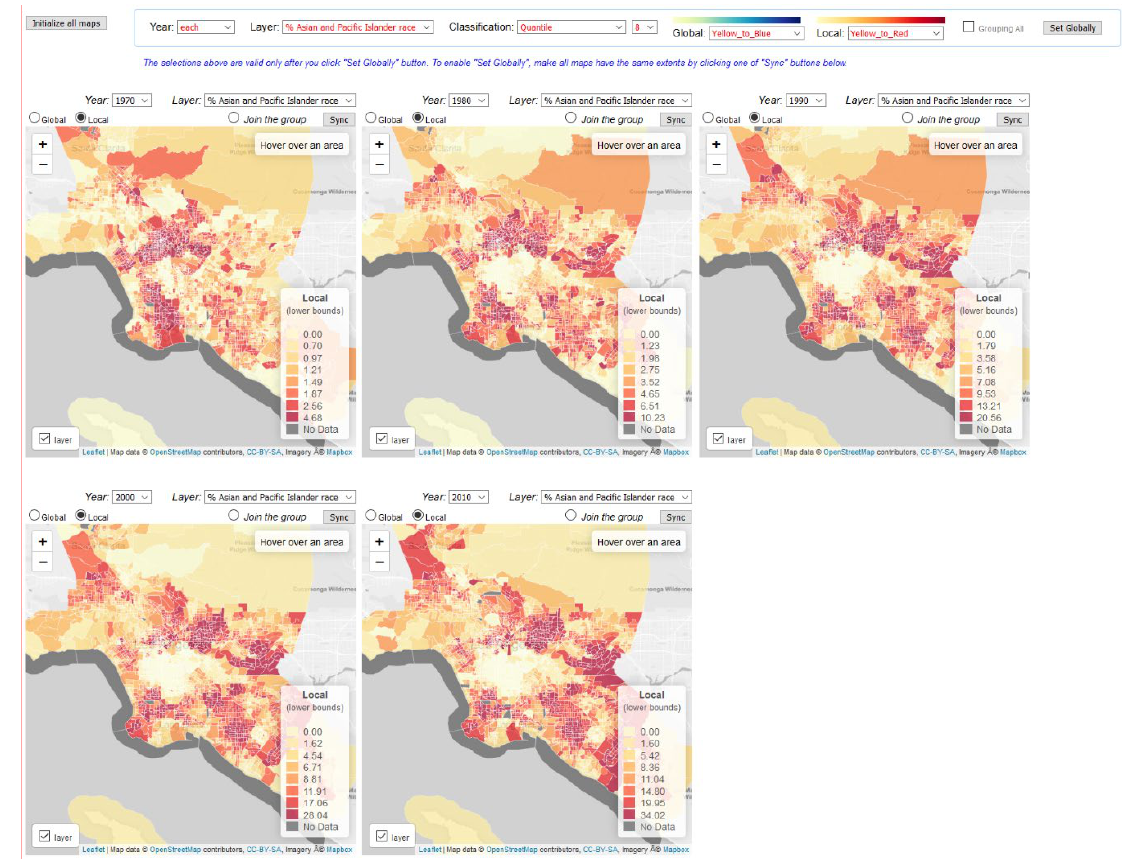
Figure 5. The percentage of Asians and Pacific Islanders with different class intervals of each map; it is one of the views created from the Adaptive Choropleth Mapper.